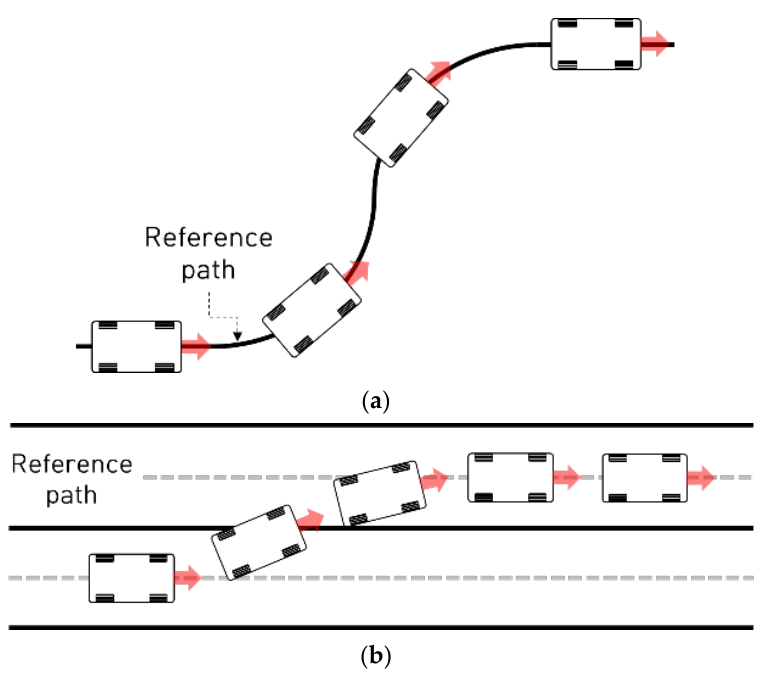
Sensors 2023 , 22 , x FOR PEER REVIEW Figure 3. Two evaluation scenarios for performance evaluation: ( a ) Curved path-tracking scenario. ( b ) Lane change scenario.